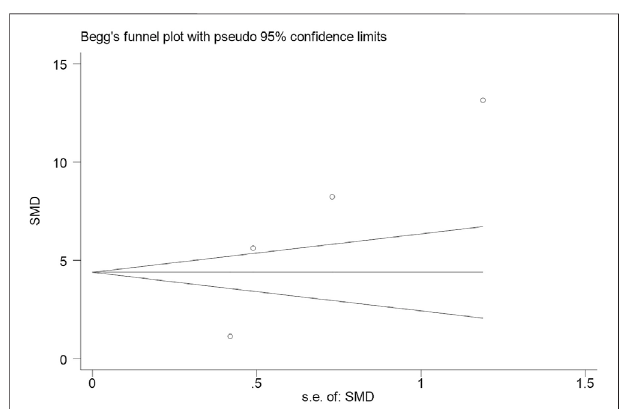
FIGURE4| FunnelplotofstudiesbyStataforfourstudiesincludedinthe meta-analysis. No signi fi cant publication bias in the meta-analysis for the difference of serum level of CRP between childhood epilepsy and healthy controls ( p =